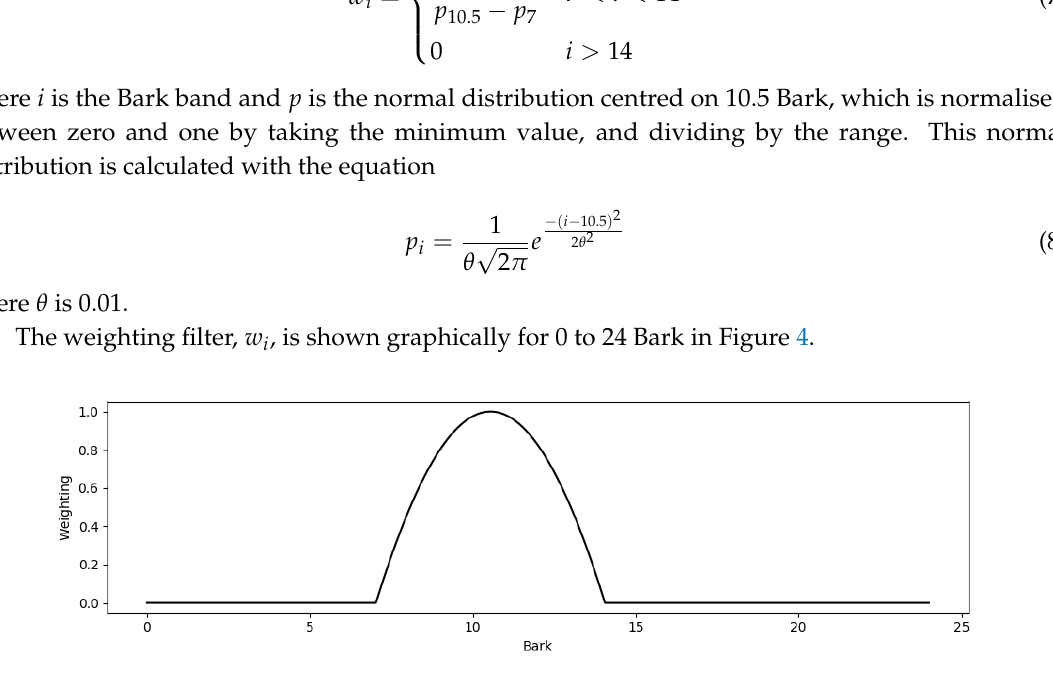
Figure 4. Weighting function for midband